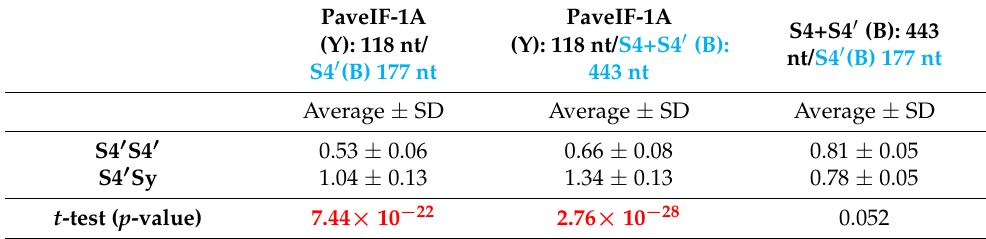
Figure 6. A representative output of fragment analysis for S4 ′ S4 ′ and S3S4 ′ as a prototype of S4 ′ Sy genotypes. Figure 6. ArepresentativeoutputoffragmentanalysisforS4 (cid:48) S4 (cid:48) andS3S4 (cid:48) asaprototypeofS4 (cid:48) Sygenotypes. Table 6. A comparison of S4 ′ S4 ′ and S4 ′ Sy genotypes. Ratios of respective peak heights were calcu- Table 6. A comparison of S4 (cid:48) S4 (cid:48) and S4 (cid:48) Sy genotypes. Ratios of respective peak heights were lated and compared. The le tt er in parentheses indicates the channel a speci fi c peak is detected in Y calculated and compared. The letter in parentheses indicates the channel a specific peak is detected yellow (represented by a black color for contrast); B blue. SD: standard deviation. in Y yellow (represented by a black color for contrast); B blue. SD: standard